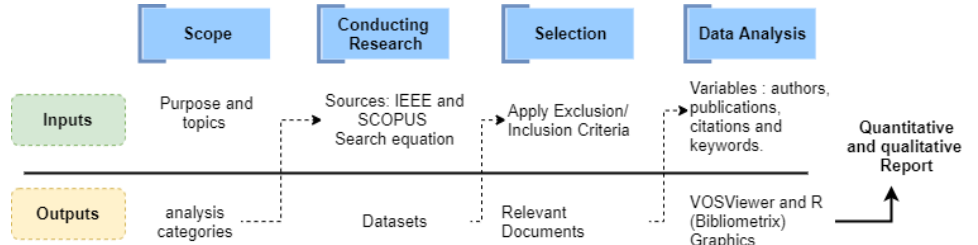
Figure 1. Protocol followed for the bibliometric analysis carried out in this